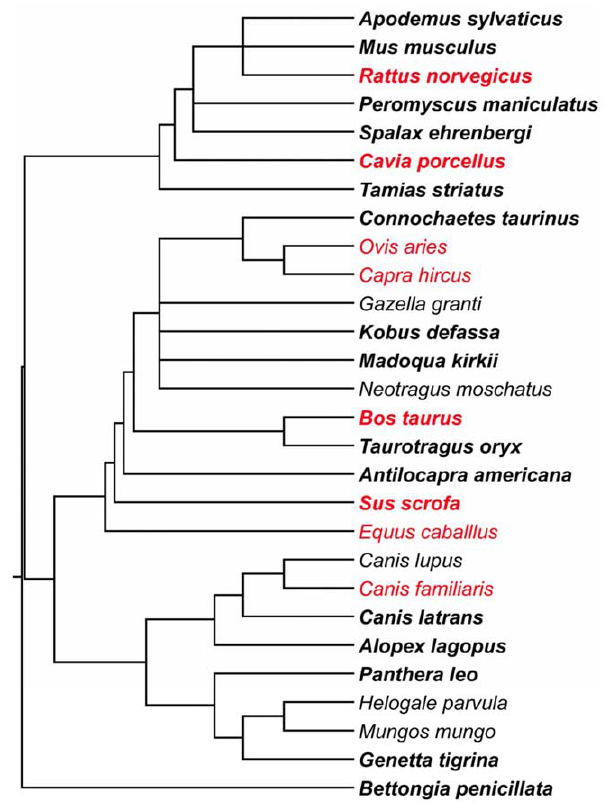
Figure 1. Phylogeny used in this analysis. Taxa which are not included in the wild sample are shown in red. Taxa in bold have BMR data in addition to MMR data. Branch lengths shown here were assigned following Nee